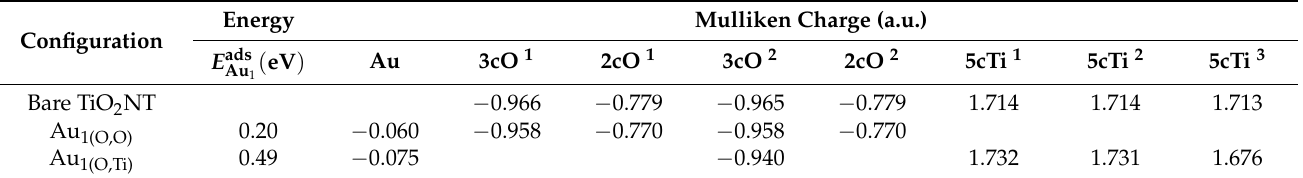
Figure 2. Top views of detailed adsorption structures for a single Au adatom on the TiO 2 NT (6,0) surface: ( a ) Au 1(O,O) ; ( b ) Au 1(O,Ti) . Table 1. Adsorption and clustering energies of Au 1 and atomic Mulliken charges of Au and TiO 2 NT surface atoms for the Au 1 /TiO 2 NT system in different configurations a